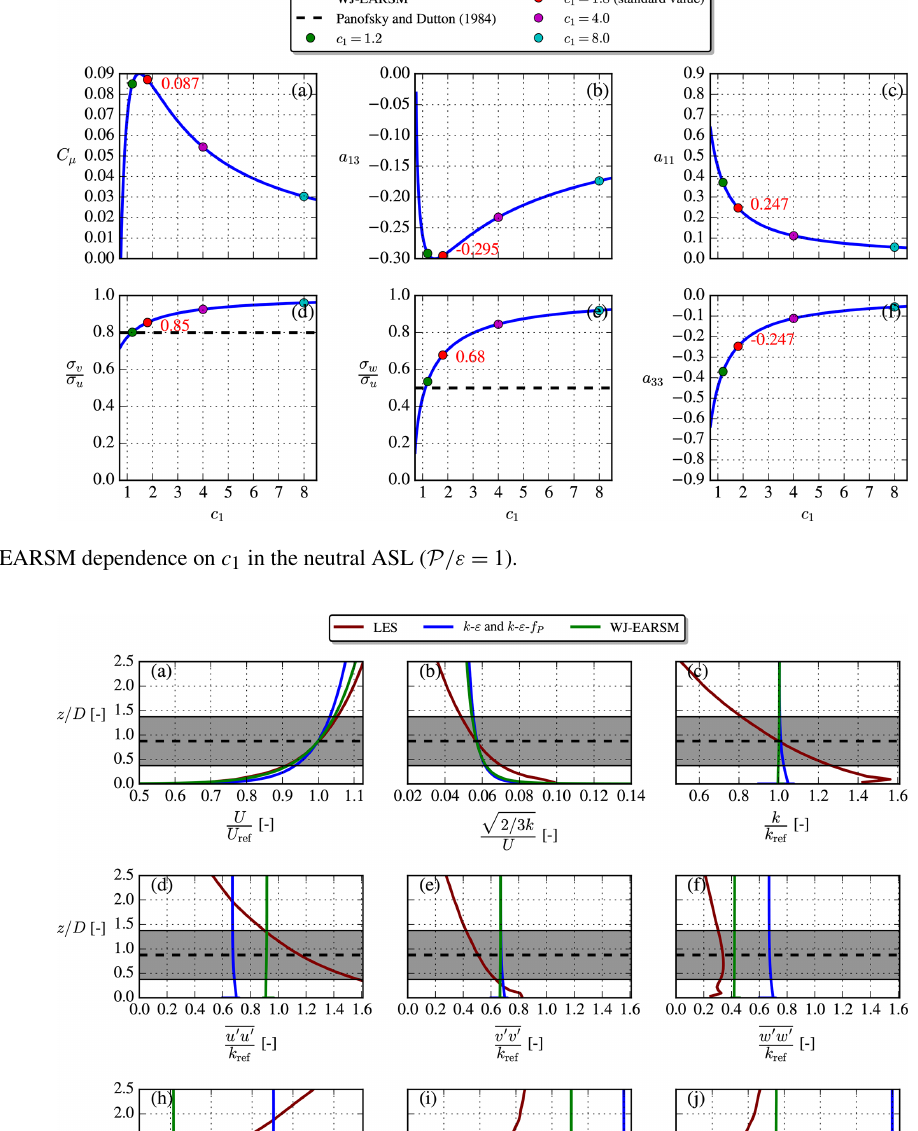
= 2 u (cid:48) u (cid:48) k , whereas the WJ-EARSM turbulence is α α 3